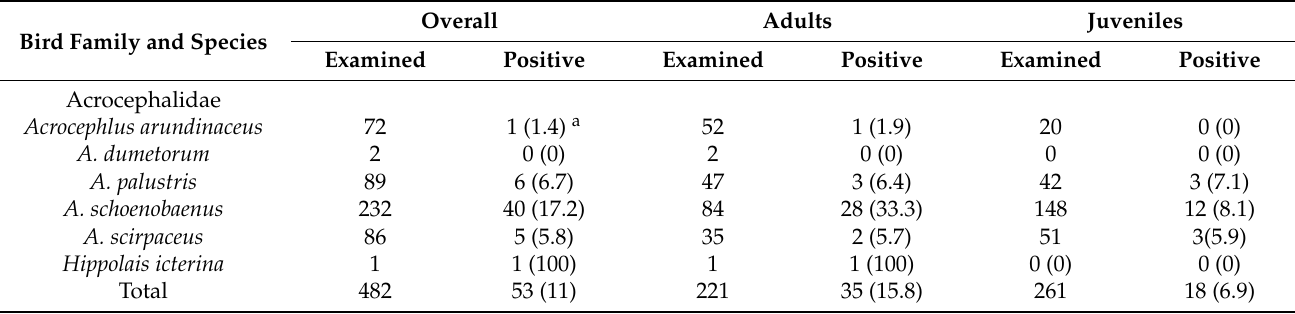
Table 2. Prevalence of Lankesterella parasites in adult birds of several Passeriformes families and juveniles of Acrocephali- dae